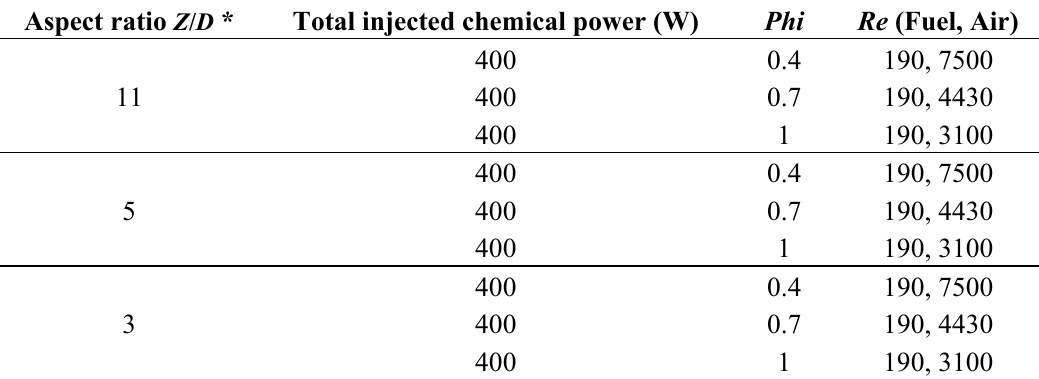
Table 1. Operating conditions of 9